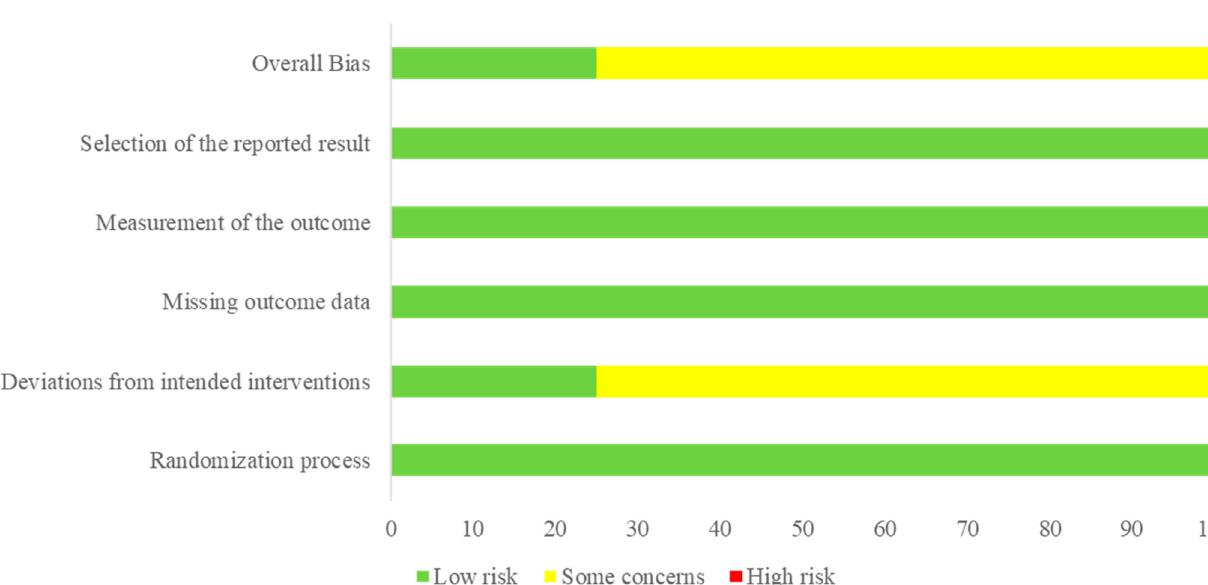
Figure 2. Quality of included studies.